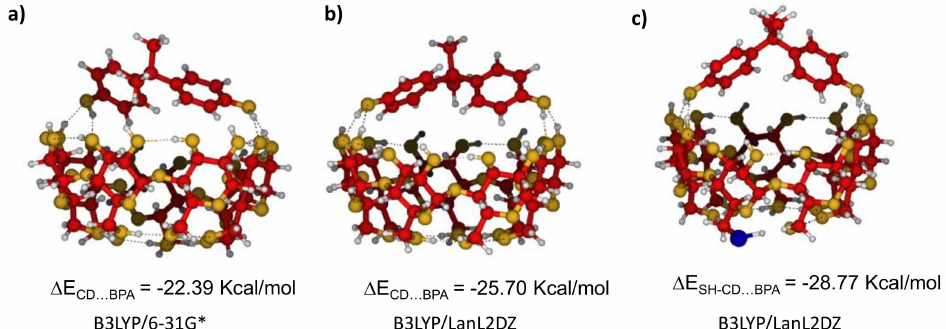
Figure 4. Optimized geometries and calculated interaction energies of the complex formed between BPA and CD ( a , b ) or SH-CD ( c